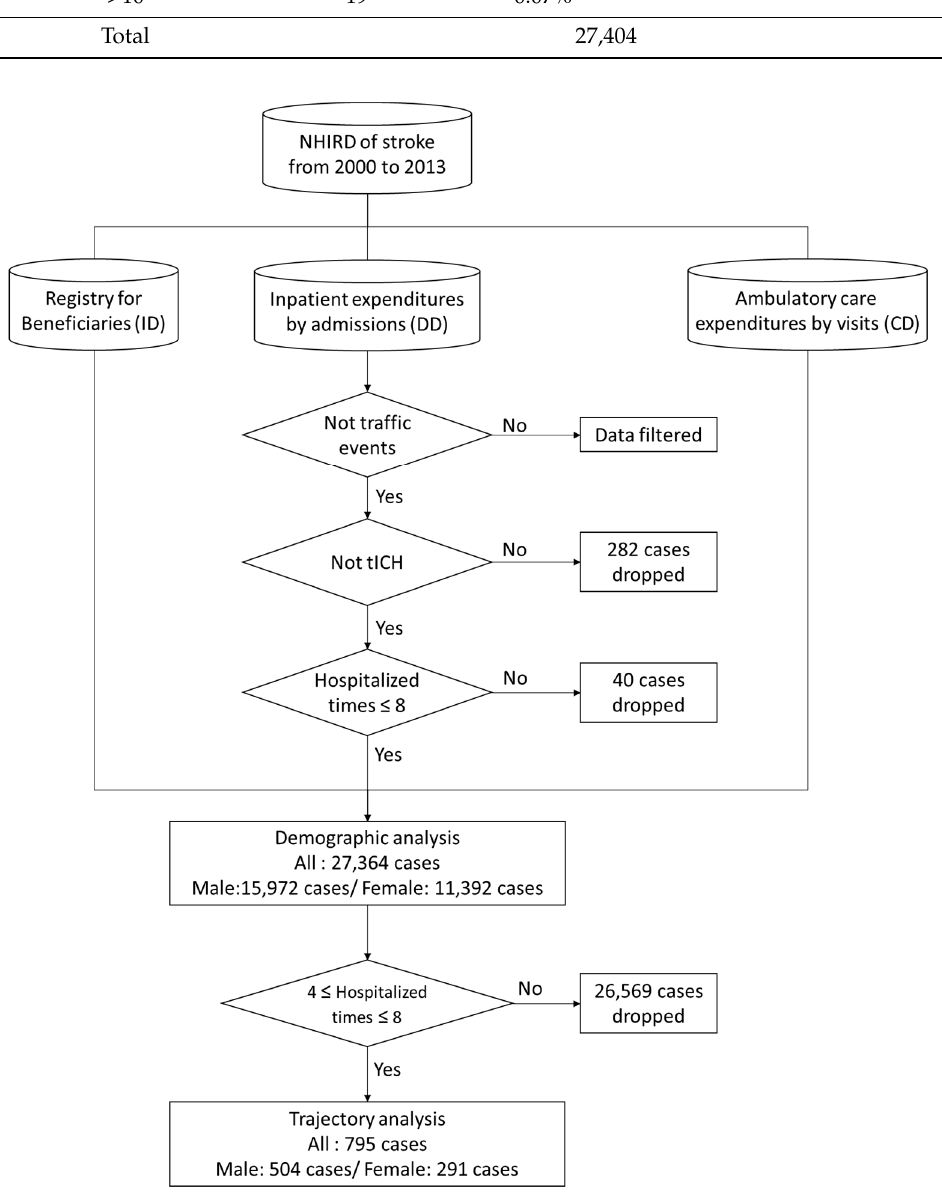
Figure 1. Flow chart describing management of data from the National Health Insurance Research Database in Taiwan. tICH: Traumatic Intracranial Hemorrhage Table 1. Patient hospitalization statistics.